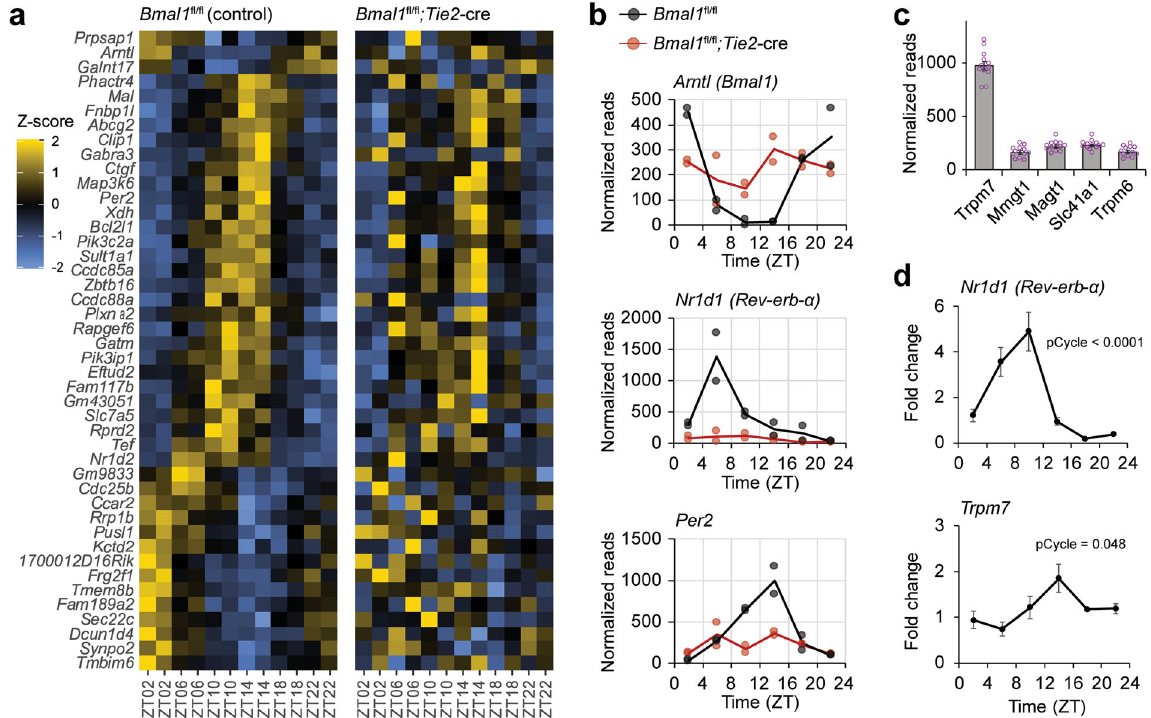
Fig. 3 Cycling of circadian clock genes and a highly expressed magnesium transporter in brain endothelial cells. Control or endothelial-cell speci fi c Bmal1-de fi cient mice were collected at ZT2, ZT6, ZT10, ZT14, ZT18, and ZT22 ( n = 12; 6 time points, 2 independent experiments); brains were dissected and endothelial cells were isolated by FACS using CD31 antibody. RNA was extracted and sequenced with HiSeq. a Few transcripts cycle in BBB endothelial cells. Heatmap of cycling transcripts of control animals (Meta2d, q < 0.6) is organized by peak and trough with corresponding transcripts of Bmal1 -de fi cient endothelial cells. b Expression of core circadian genes shows robust rhythms in mouse BBB. Transcripts of controls (black) are rhythmic (pCycle <0.001) while Bmal1 -de fi cient endothelial cells (red) are not. pCycle values were calculated by Meta2d analysis adjusted for multiple comparisons. c Trpm7 is highly expressed in BBB endothelium. Expression of known magnesium transporters in controls ( n = 12; 2 independent experiments) are shown as means ± SEM. d Trpm7 shows rhythmic expression in brain endothelial cells. qPCR of sorted brain endothelial cells ( n = 24; 6 time points, 4 independent experiments) were probed for Nr1d1 and Trpm7 expression across the circadian day normalized to GAPDH . pCycle values were calculated by JTKCycle